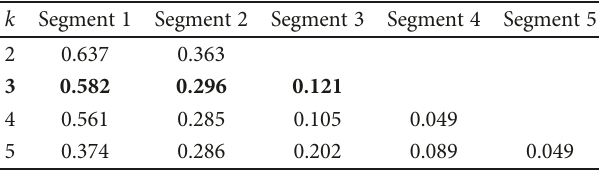
Table 8: Relative segment